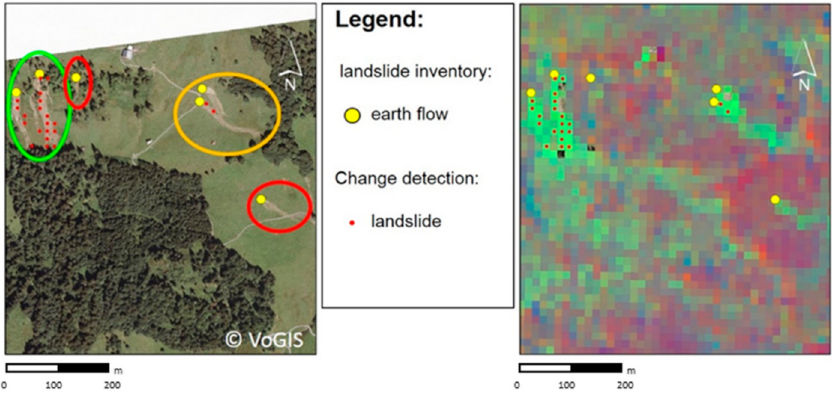
Figure 18. Landslide classification results in the area of Hintereggalpe (as seen in Figure 4b).